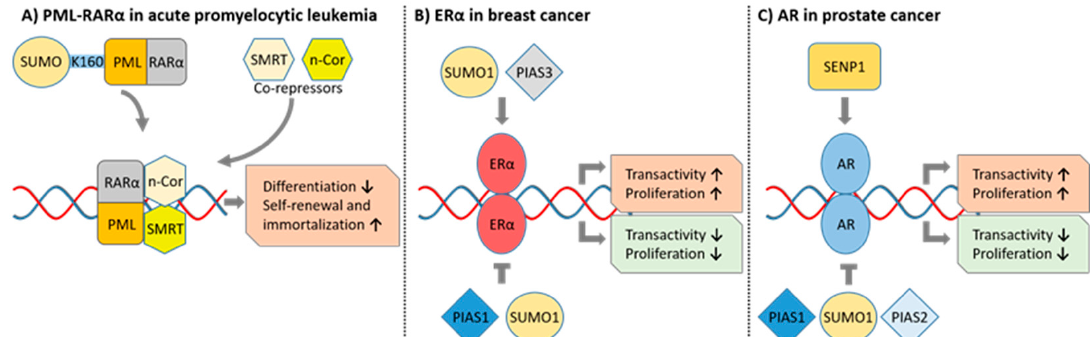
Figure 2. Examples of SUMO-modification regulation of key oncogenic substrates. ( A ) SUMOylation of PML-RAR α in K160 and recruitment of co-repressors is required for APL cell differentiation blockade, self-renewal and immortalization. ( B ) PIAS3 promotes transactivation of estrogen receptor α (ER α ) and proliferation of breast cancer cells via SUMO-dependent and independent mechanisms, whereas PIAS1 has a predominantly repressive effect on ER α . ( C ) SENP1-mediated deSUMOylation of androgen receptor (AR) promotes AR-dependent transactivation and proliferation of prostate cancer cells that is counteracted by PIAS1- and PIAS2-induced SUMO1-modification of AR.